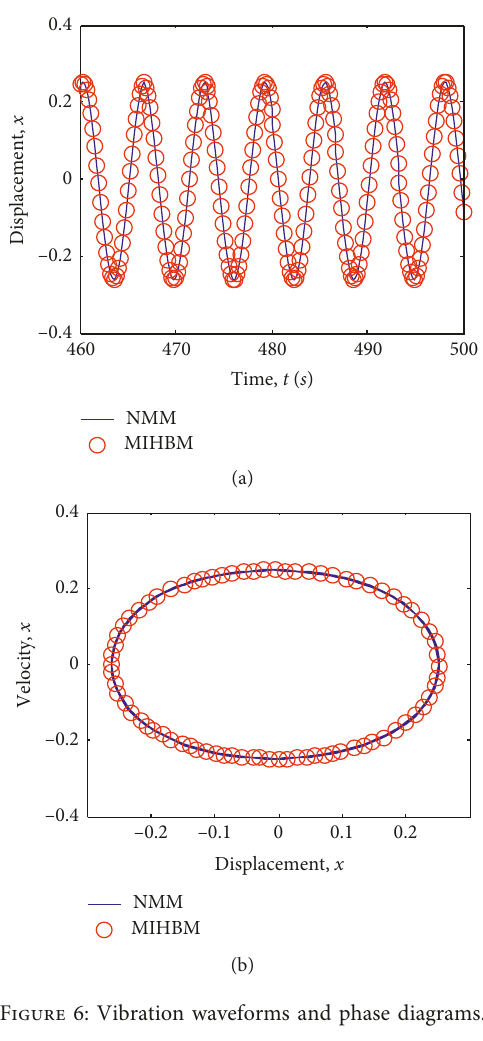
Figure 6: Vibration waveforms and phase diagrams.